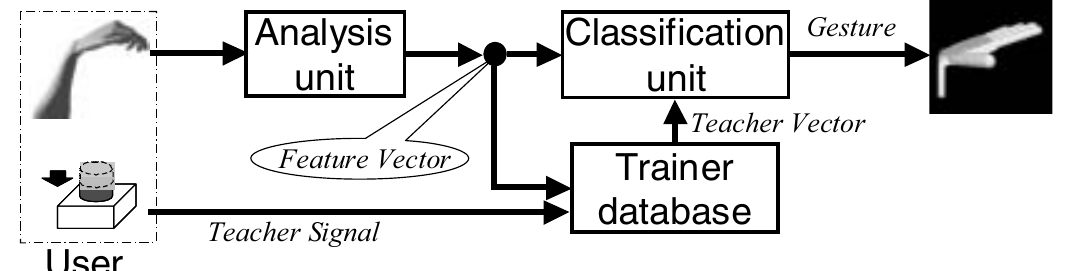
Figure 2 Composition of an online EMG-to-gesture classifier.